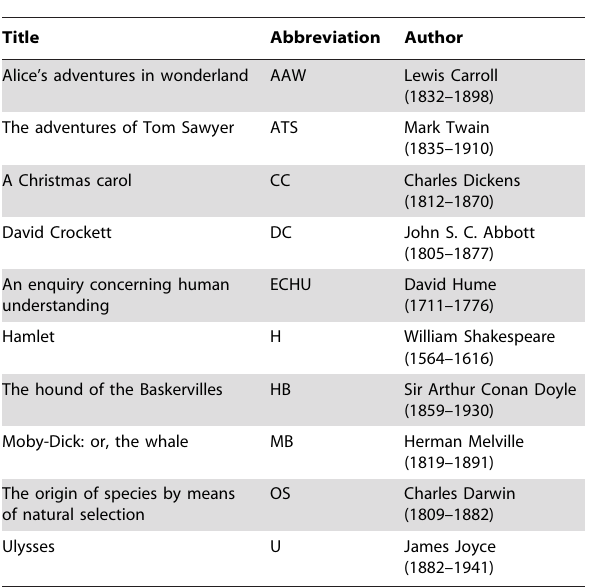
Table 1. Summary of English texts employed.